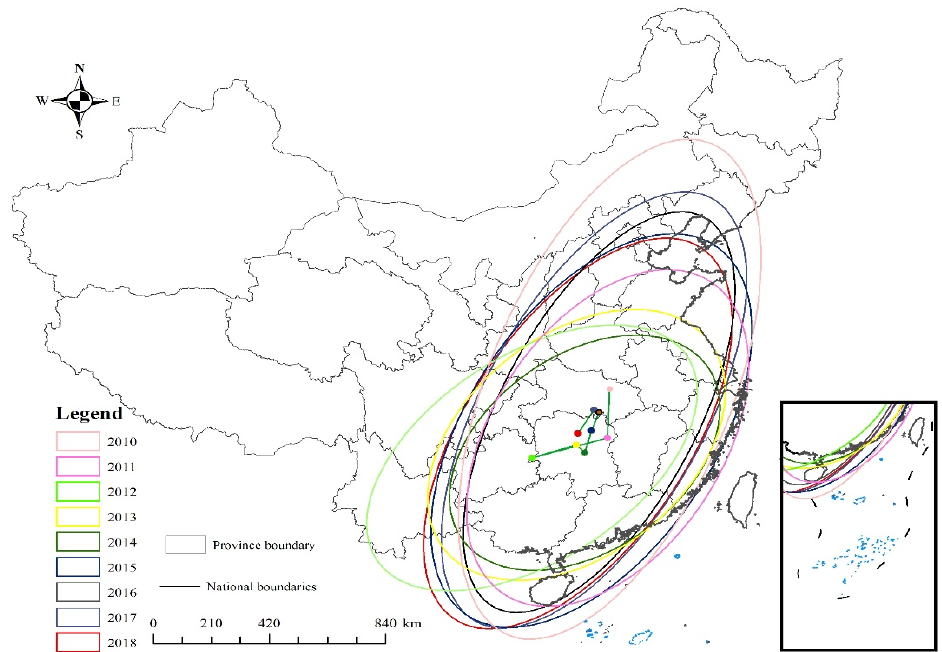
Figure 6. 2010–2018 China forest fi re standard deviation ellipse.